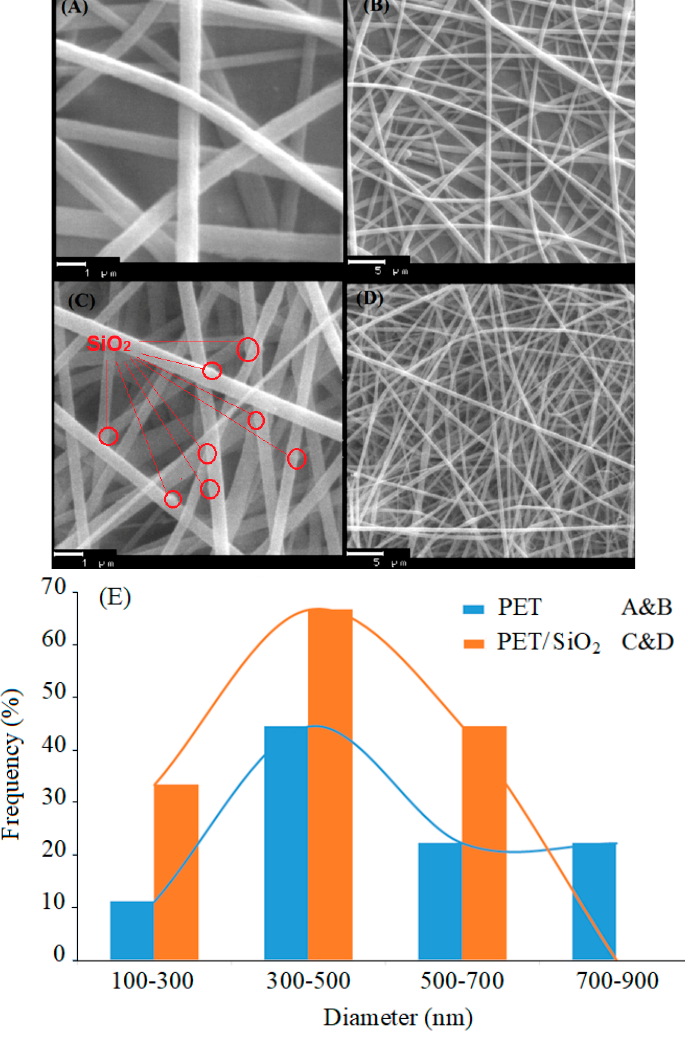
Figure 4. The SEM images of ( A , B ) electrospun PET and ( C , D ) PET/nano-SiO 2 . ( E ) histogram for size distribution of fabricated